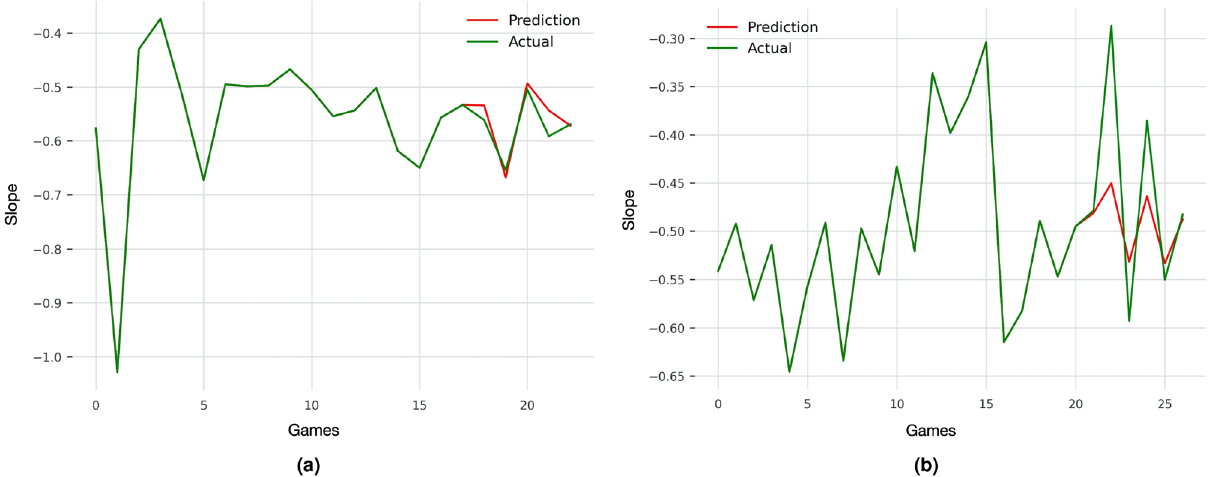
Figure 5. Example A-V profiles slopes forecasting using the uni-modal averaged ensemble. (a) represents the best prediction, (b) is the median prediction. Note that the red line represents the prediction made on the testing data